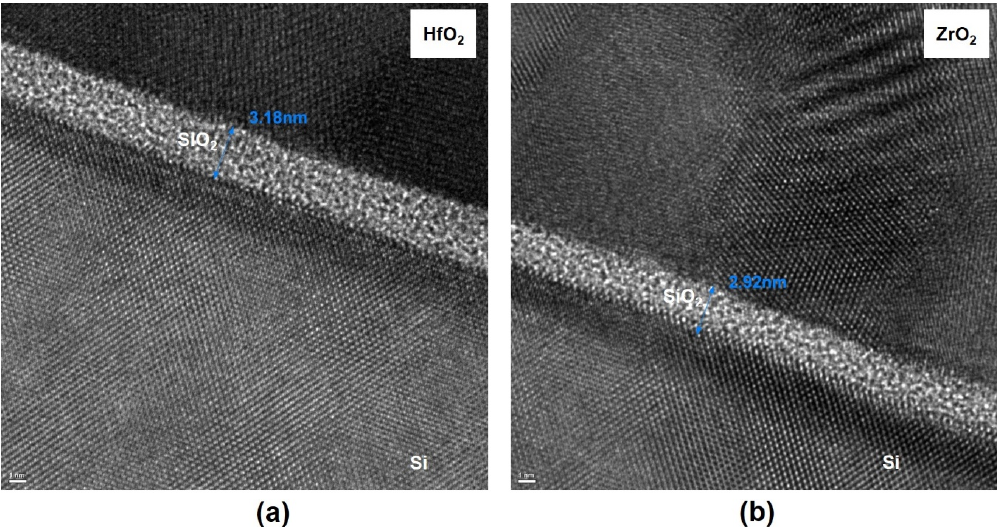
Figure 6. ( a ) High-resolution transmission electron microscopy (HRTEM) image of the cross section of the HfO 2 thin film; ( b ) HRTEM image of the cross section of the ZrO 2 thin film.